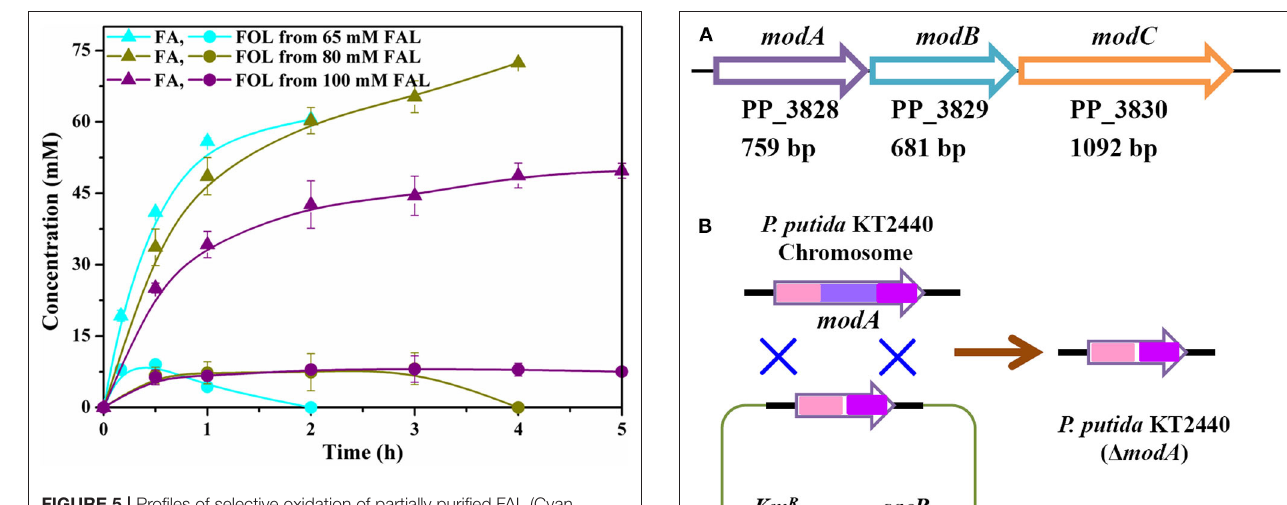
KT2440, evidenced by the conversion of HMF to HMFCA (Xu et al.,